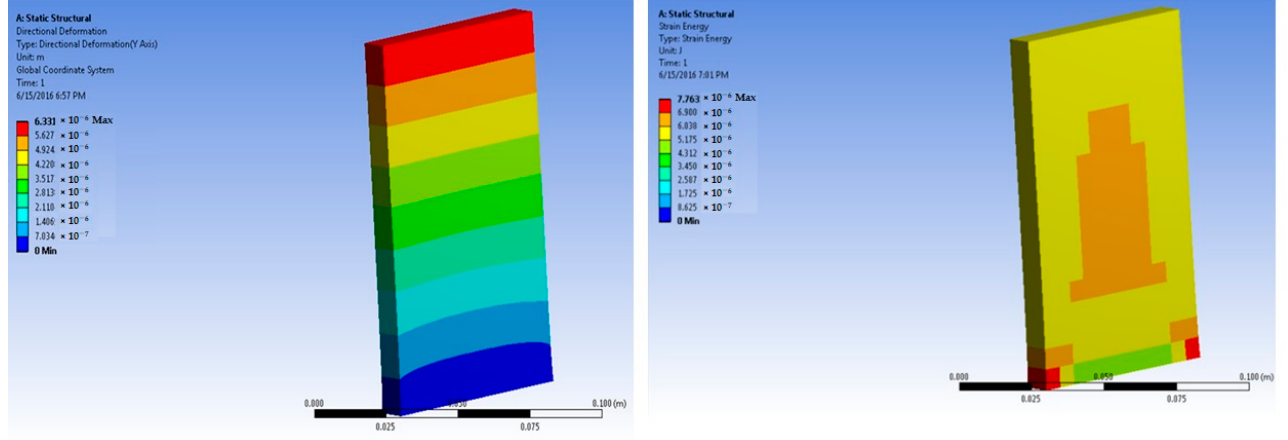
Figure 22. Three percent coarse-aggregate-based concrete slab at 700 × 10 5 N force (deformation and strain